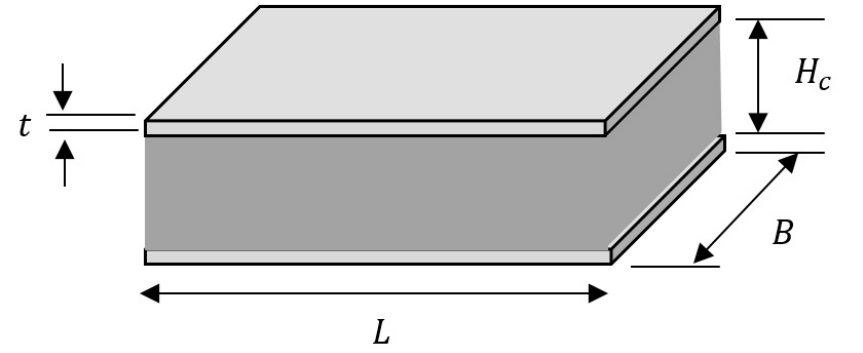
Fig. 1. Schematic representation of sandwich structure with relevant dimensions shown Sandwich beam failure modes vary significantly depending on the materials used and the beam dimensions. Some common failure modes include: tensile and compres- sive failure of the face sheets, delamination at the core/face interface, indentation failure at the load point, core failure (usually by shear), wrinkling of the face sheets, and global buckling [28],